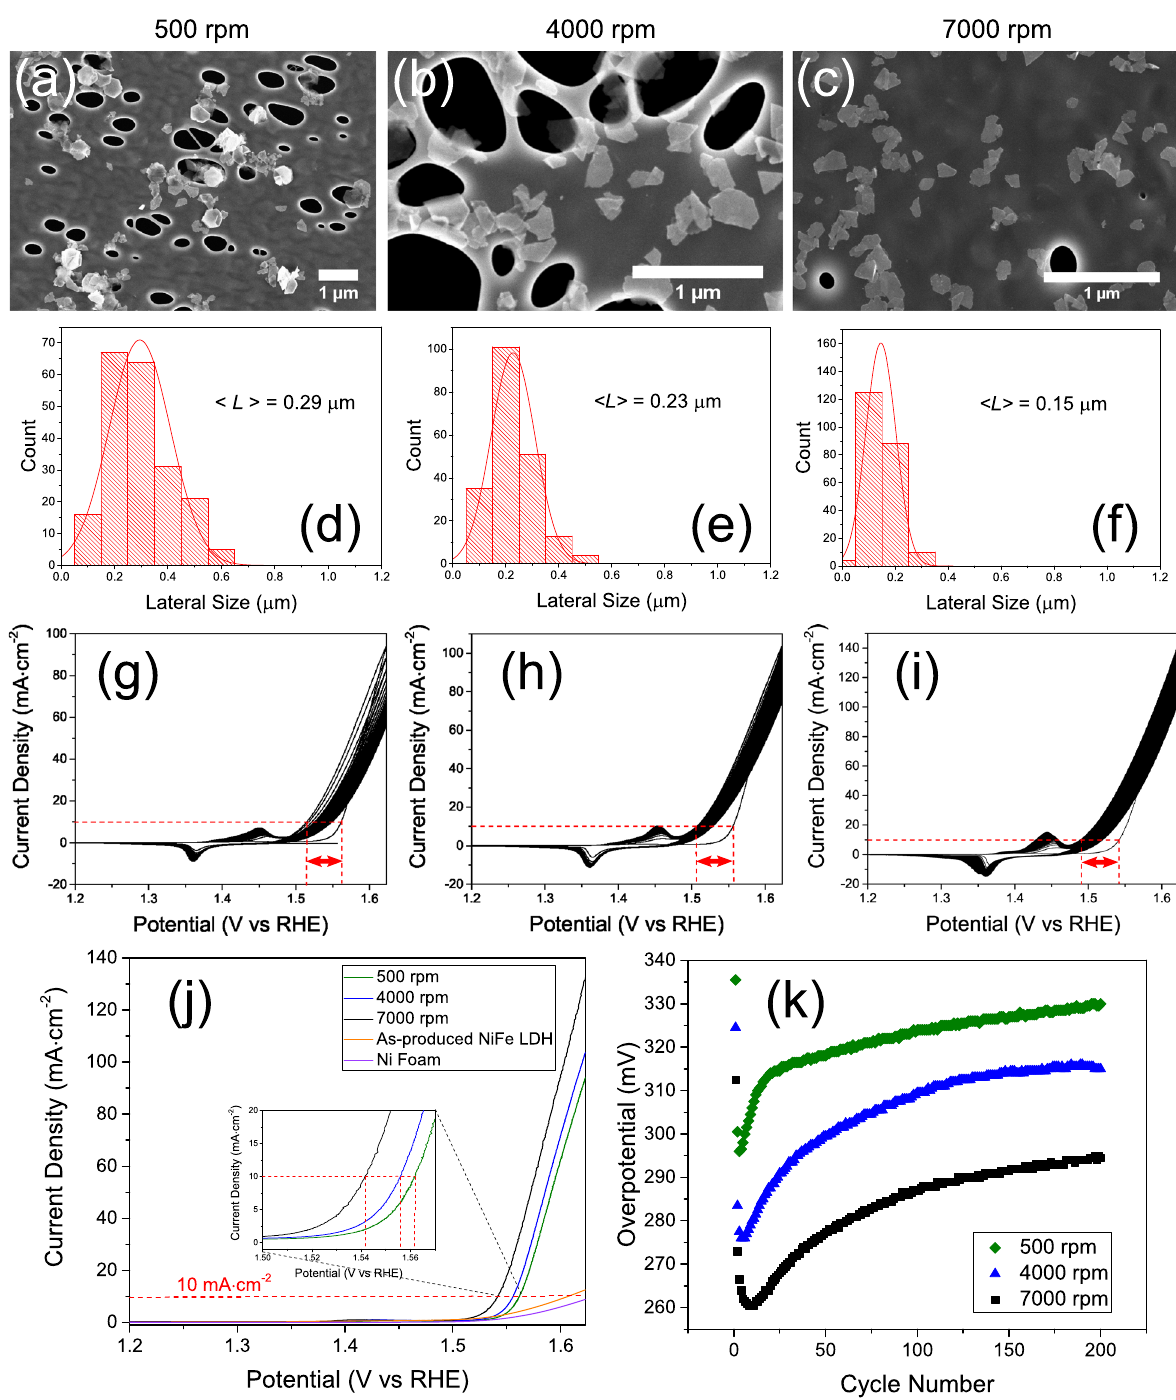
Fig. 3 Summary of the relationship between controlled platelet sizes and electrocatalytic output. a – c SEM micrographs and d – f accompanying size-distribution histograms for the sr-NiFe LDH with fi nal centrifugation rates 500, 4000, and 7000 rpm, respectively. g – i CVs over 200 cycles for each of the respective electrodes. Quoting the anodic potentials at 10 mA.cm − 2 of successive cycles allowed the overpotentials to be tracked during an extended catalyst lifetime. j Initial polarization curves for electrodes prepared with each dispersion and k overpotentials as a function of cycle number, averaged over two-electrode samples in each case (full data in Supplementary Fig. 9a). Scale bars are 1 μ m in ( a , b , and c